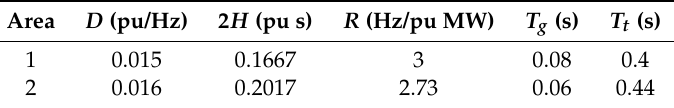
Table 1. Parameters of a two-area LFC